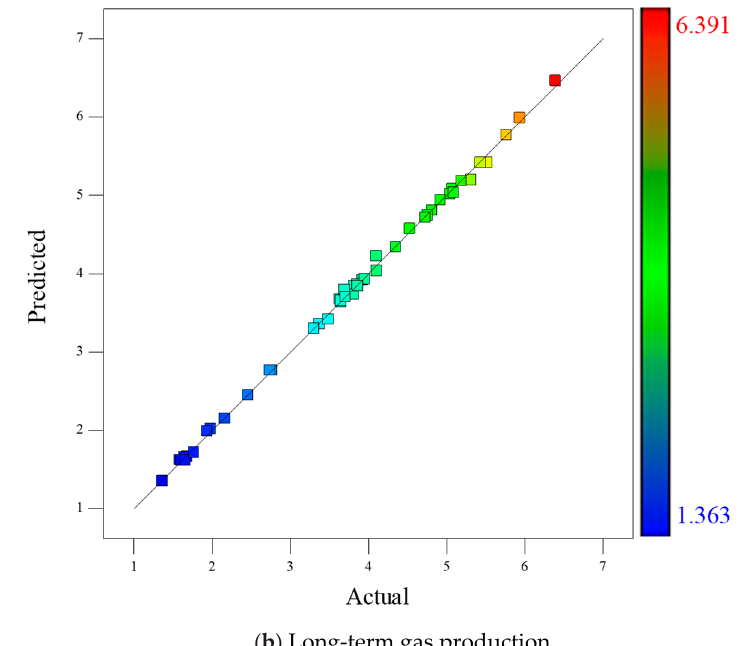
Figure 9. Predicted √(cid:1833)(cid:1844)(cid:1844) versus actual √(cid:1833)(cid:1844)(cid:1844) plot at different production periods. √ √ GRR versus actual GRR plot at different production periods. Figure 9. Predicted √𝐺𝑅𝑅 versus actual √𝐺𝑅𝑅 plot at different production periods. Figure 9. Predicted